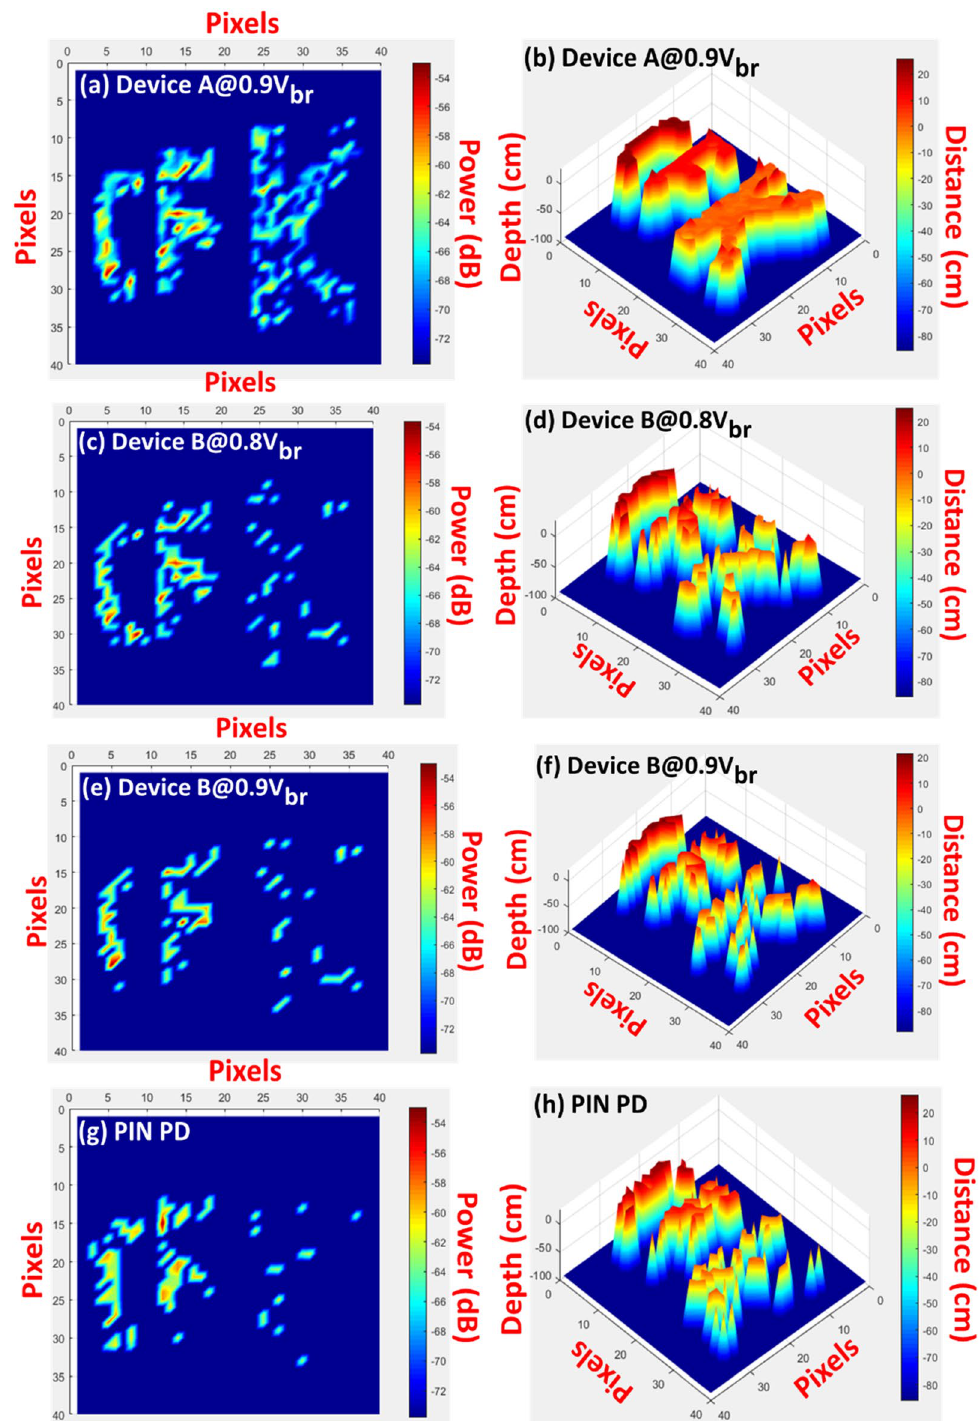
Figure 15. ( a , c , e , g ) shows captured LiDAR images corresponding to the measured IF power of each pixel from Device A at 0.9V br , Device B at 0.8V br , Device B at 0.9V br and the p-i-n PD. ( b , d , f , h ) shows captured LiDAR 3D images based on the depth and distance information of each pixel from Device A at 0.9V br , Device B at 0.8V br , Device B at 0.9V br and the p-i-n